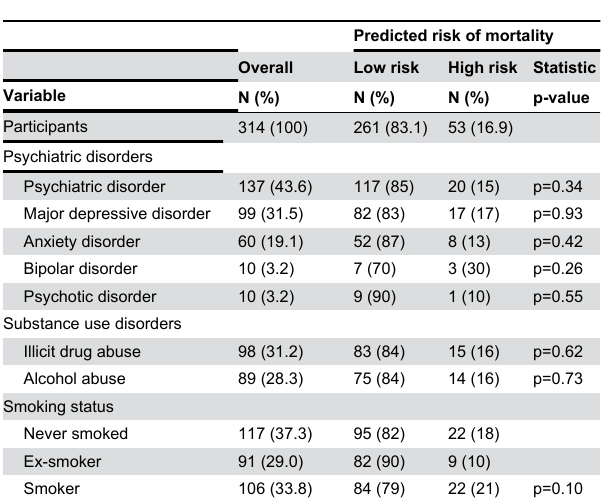
doi: 10.1371/journal.pone.0078403.t003